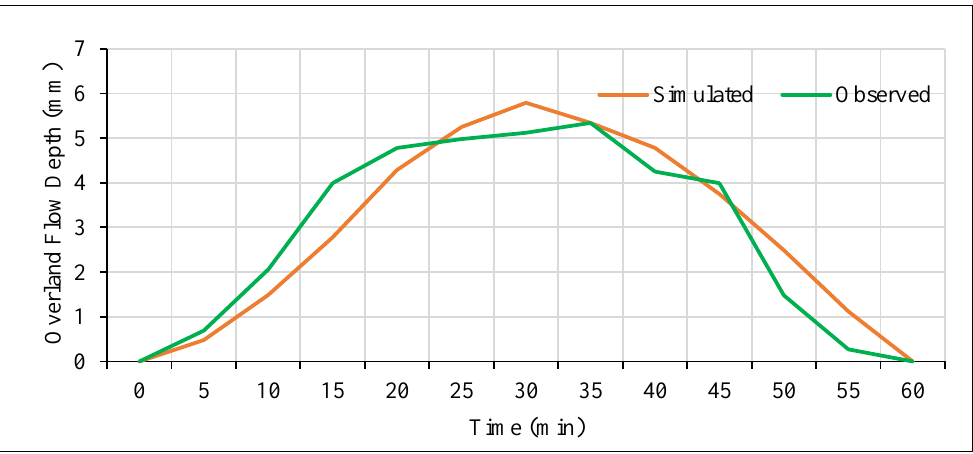
Figure 12. Overland flow hydrograph for rainfall intensity of 100 mm/h for 30 min.